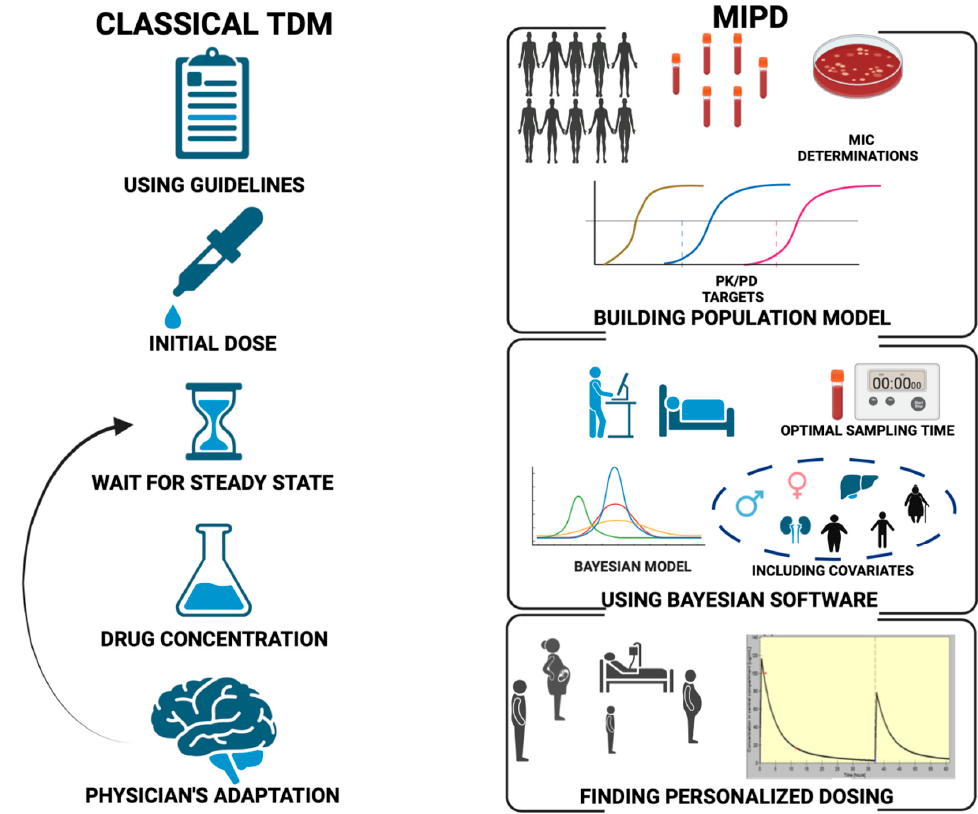
Figure 3. Comparison of the traditional TDM ( left ) and MIPD ( right ) workflows. MIC: minimum inhibitory concentration; MIPD: model-informed precision dosing; PD: pharmacodynamic; PK: pharmacokinetic; TDM: therapeutic drug monitoring.